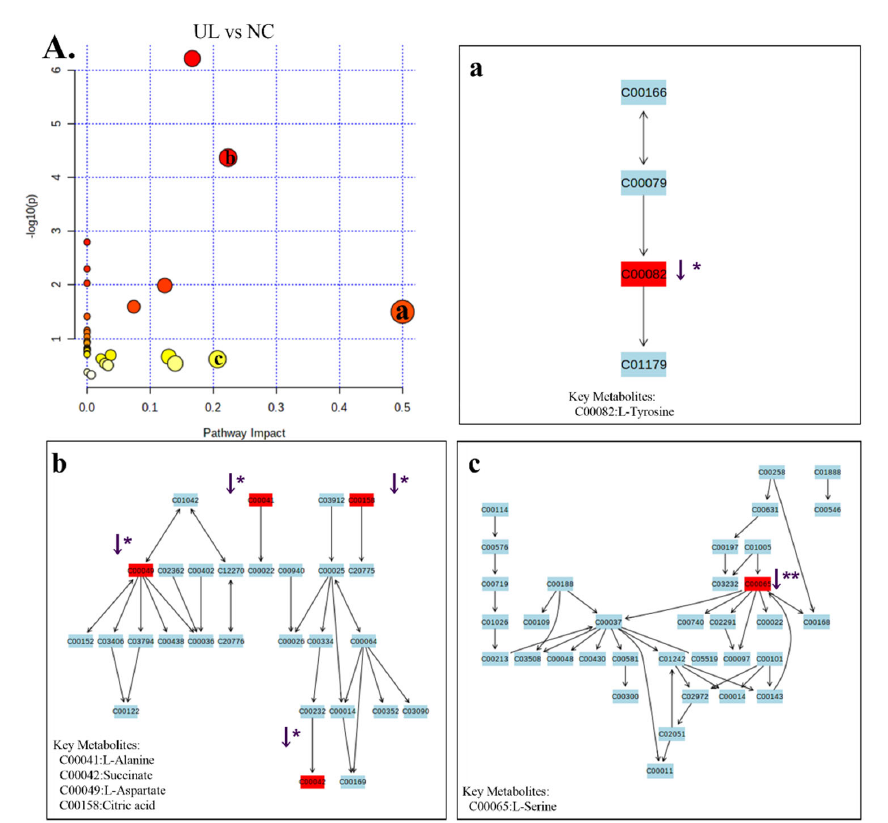
Figure 8. ( A ) Differential metabolic pathways between NC and UL groups. The color (light to dark) of the point represents the p value (Y ‐ axis), and the size of the point represents the metabolic pathway impact (X ‐ axis). ( A ( a )): phenylalanine, tyrosine and tryptophan biosynthesis; ( A ( b )): alanine, aspartate and glutamate metabolism; ( A ( c )): glycine, serine and threonine metabolism. * p < 0.05 vs. NC group, ** p < 0.01 vs. NC group.